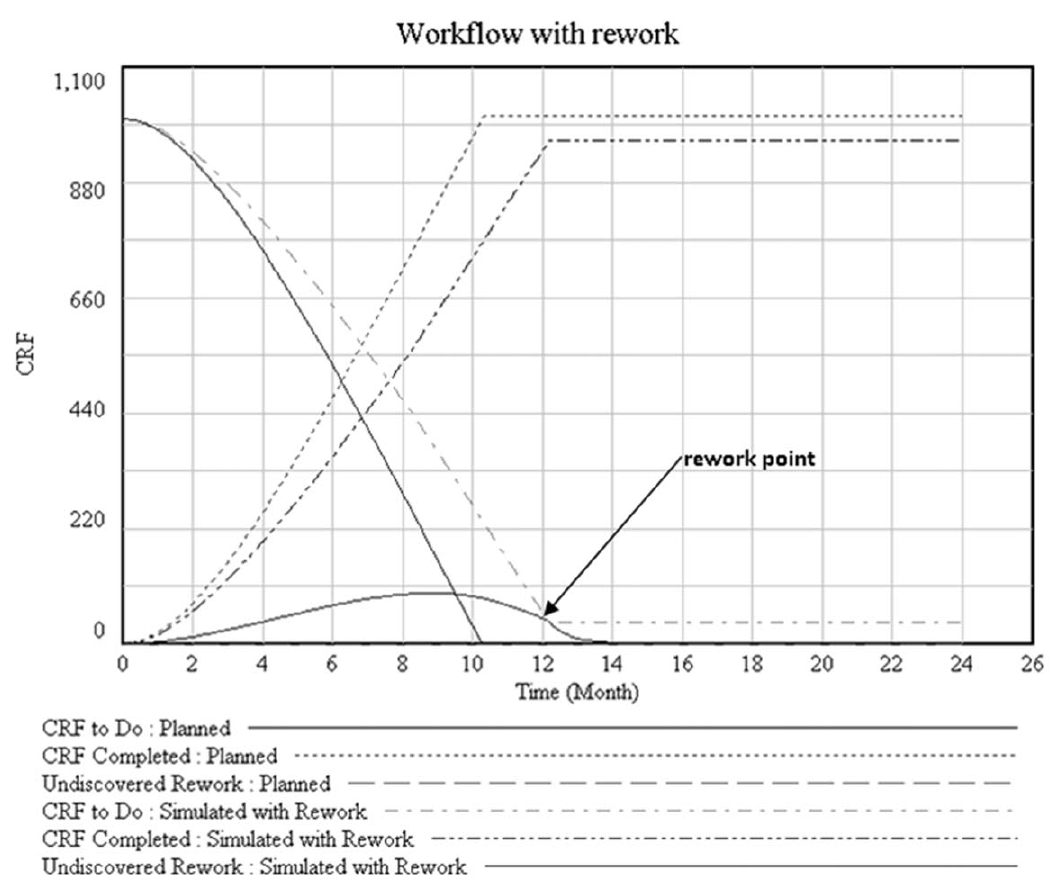
Figure 2. CRF’s to do and CRF’s completed in two situations: planned and simulated with rework.